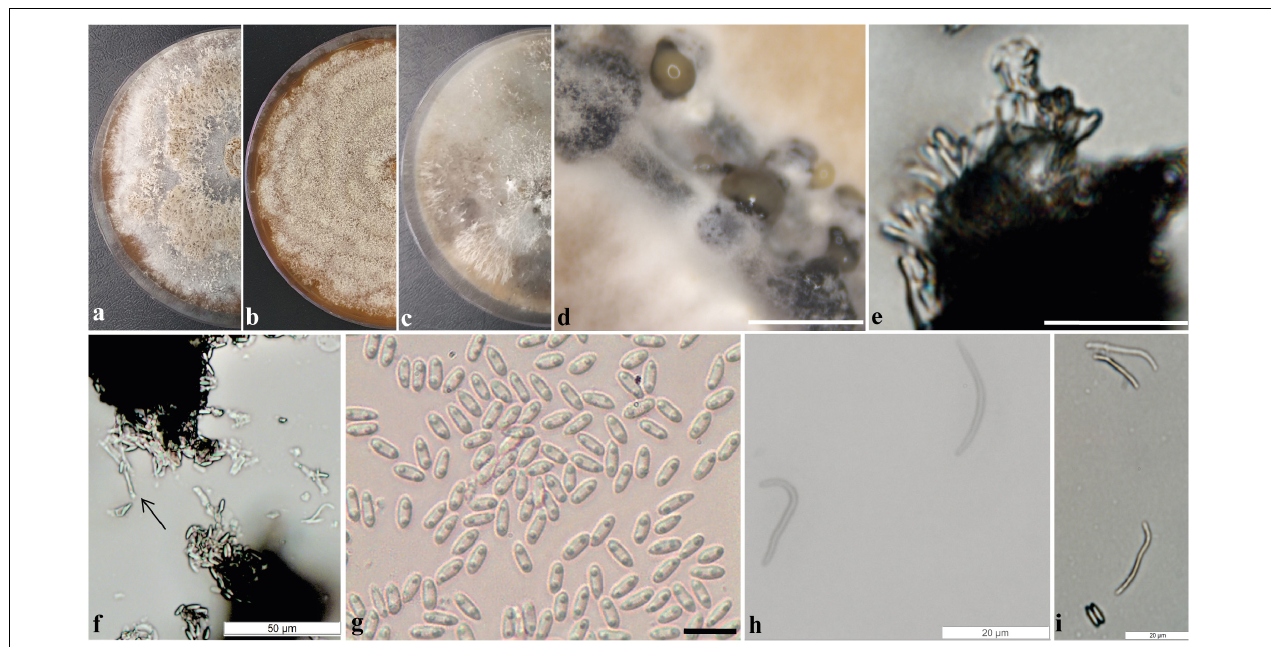
FIGURE 3 | Diaporthe cerradensis (CMRP4331). (a–c) Colonies on PDA, MEA, and OA, respectively; (d) conidiomata sporulating on PNA; (e) conidiophores; (f) conidiogenous cells; (g) alpha conidia; (h) beta conidia; and (i) alpha and beta conidia. — Scale bars: d = 200 µ m; e = 50 µ m; and g = 10 µ